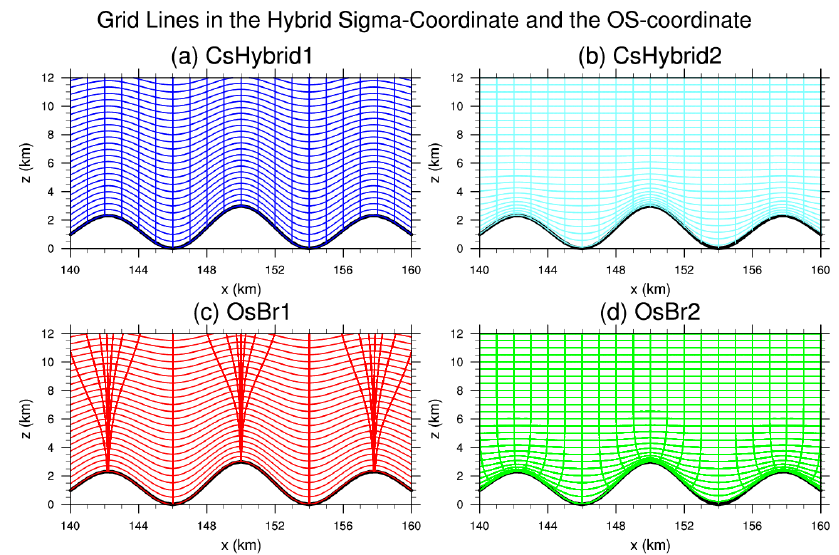
Figure 8. The vertical and horizontal grid lines in the hybrid σ coordinate and the OS coordinate . The domain is a close-up of the Schär mountain (i.e. zoomed-in version of Fig. 7). The black curve represents the terrain. Table 2. Horizontal and vertical Courant numbers of each experiment in the computational space. Velocity Time step Maximum Experiments unit:ms − 1 unit: s Courant numbers* (high and low level) Maximum U Maximum W d t Horizontal